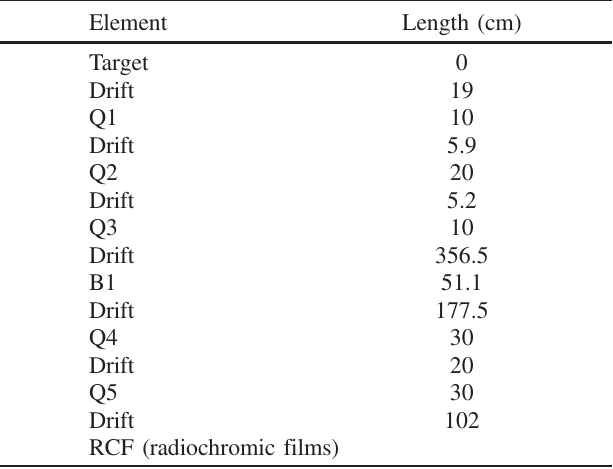
TABLE I. Length of each element along the beam line. Element